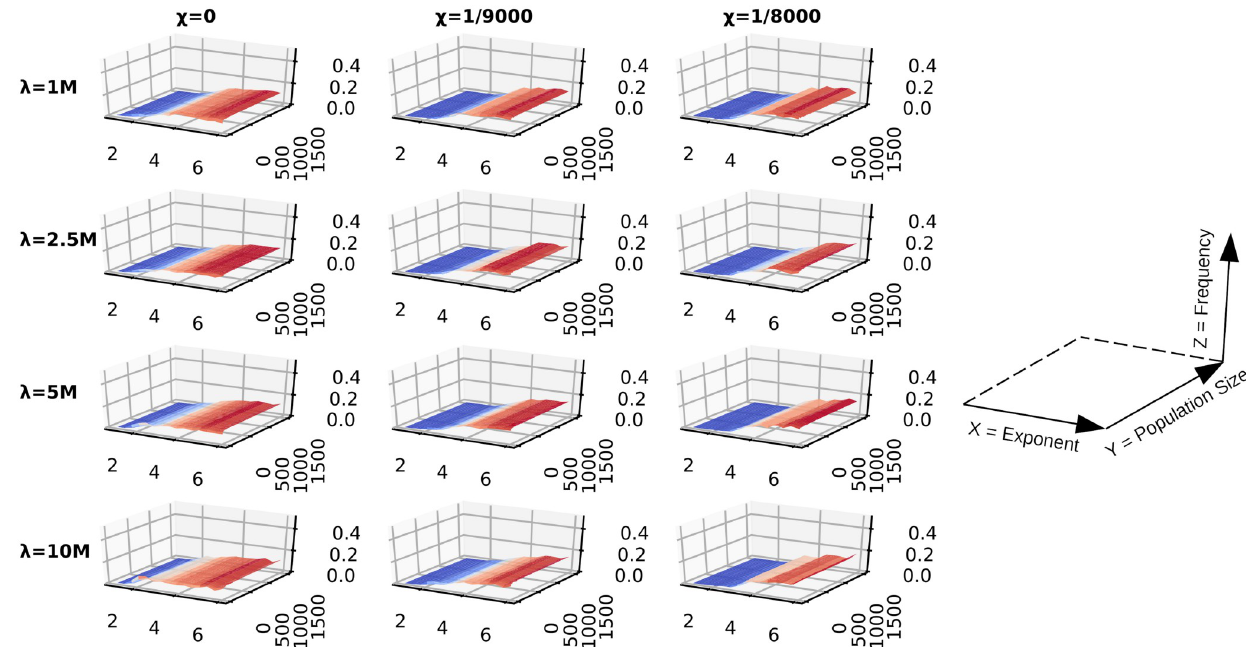
Fig 9. DO fitness landscape with LD u = 1.0 resources. A matrix of surface plots of the top 1% performing DOs from sub-populations of the single- generation simulations which traversed Le´vy dust environments with dimension u = 1.0. Fitness is determined by the average energy over a lifespan, � AOL . The matrix rows are indexed by lifespan λ , and the columns by the searching cost χ . A reference plot has been provided in order to interpret the axes of the individual surface plots; the x-axis is foraging exponent, the y-axis is population size, and the z-axis is frequency normalized to [0, 1].